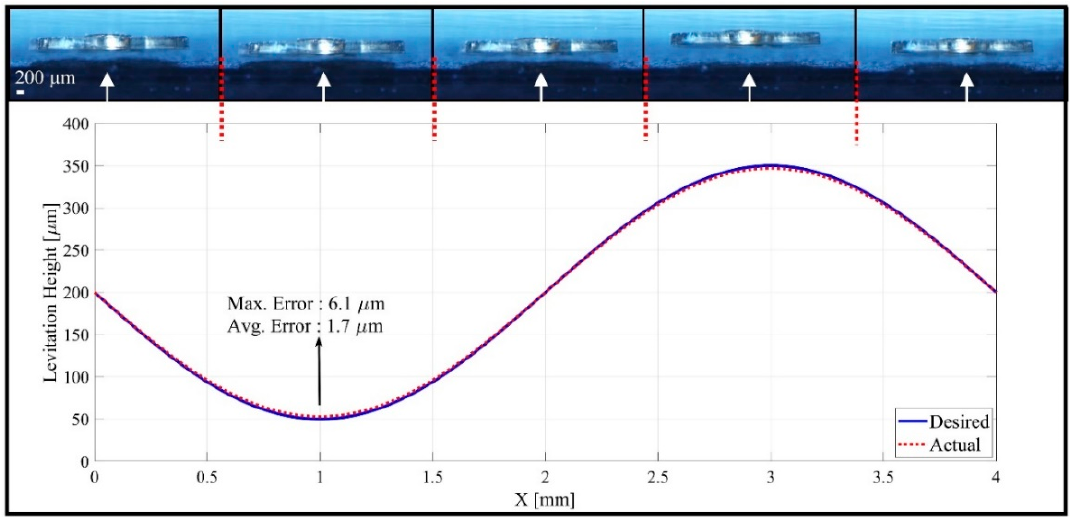
Figure 13. The experimental data represents microrobot motion on a 4 mm trajectory with a sine-wave profile relative to the x -axis by the time recording changes on levitation height relative to the z -axis. Five snapshots are given to show actual location.